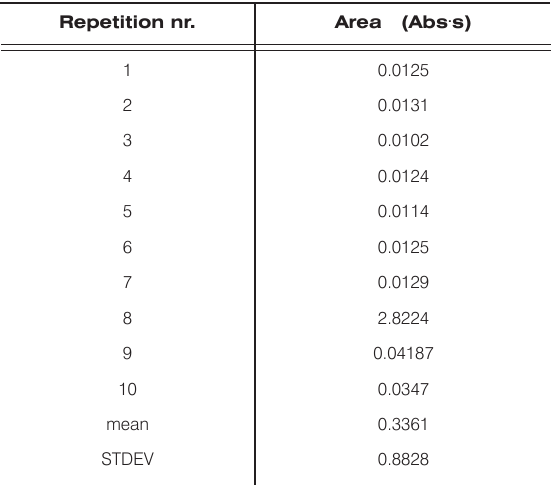
Table 2. repetitions of blanks for determination of the LOD of iron determination by GFAAS with Zeeman-background Repetition nr.